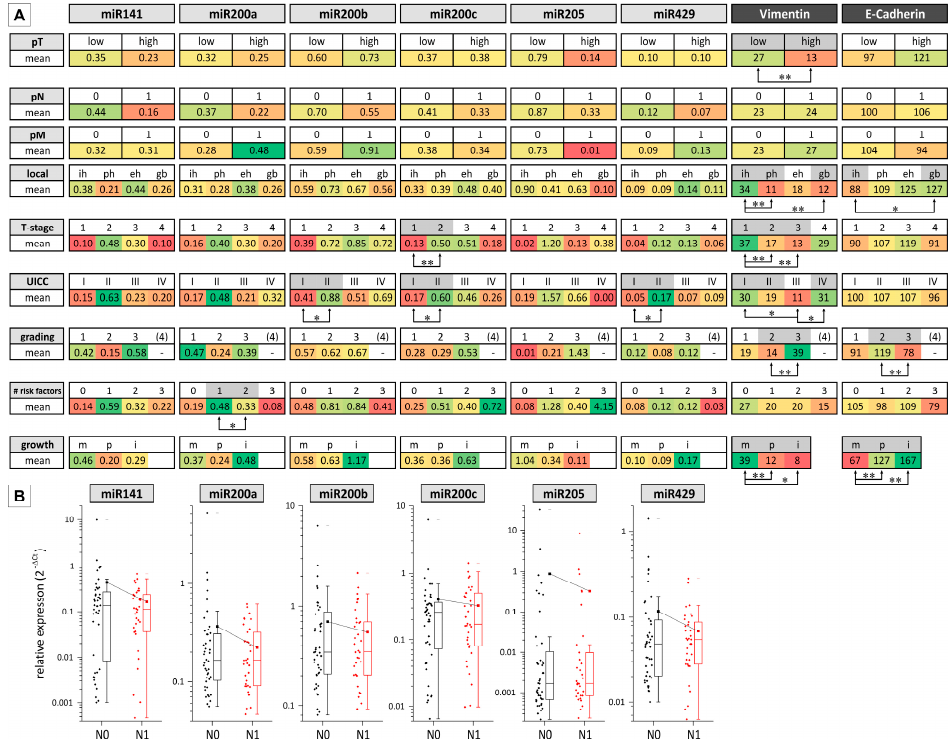
Figure 3. Association of miR200 family/miR205 expression with clinicopathological parameters for n = 78 biliary tract cancer cases. ( A ) For each variable (miRs (qRT-PCR), vimentin, E -cadherin (semi-quantitative immunohistochemistry)), the mean expression value is shown and highlighted by color (ranging from green = high expression to red = low expression). Differences between grading could be analyzed only for G1–G3 as the cohort included only one case of G4. Significant differences between the two group or more groups (calculated using a Student ′ s t -test and ANOVA/LSD (least significant difference) post hoc test, respectively) are highlighted by grey shading and arrows (* p < 0.05 and ** p < 0.01, respectively); ( B ) microRNA expression pattern exemplified for N0 and N1 groups of patient samples. Abbreviations: eh, extrahepatic; gb, gall bladder; i, intraductal; ih, intrahepatic; m, mass-forming; p, periductal; ph, perihilar.